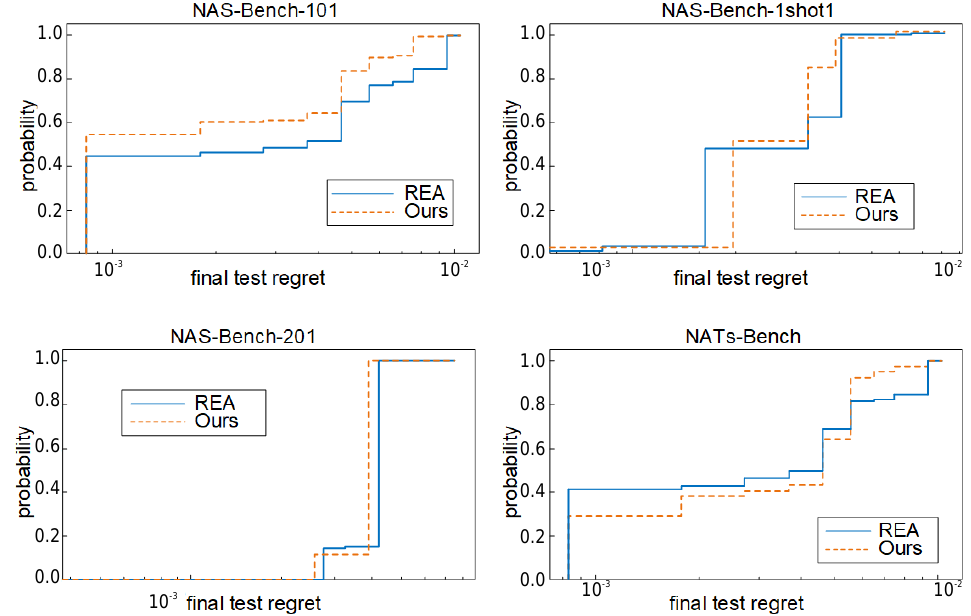
Figure 11. Compare the mean test accuracy along with error bars. Figure 10. Empirical cumulative distribution of the final test regret after 500 runs of REA and